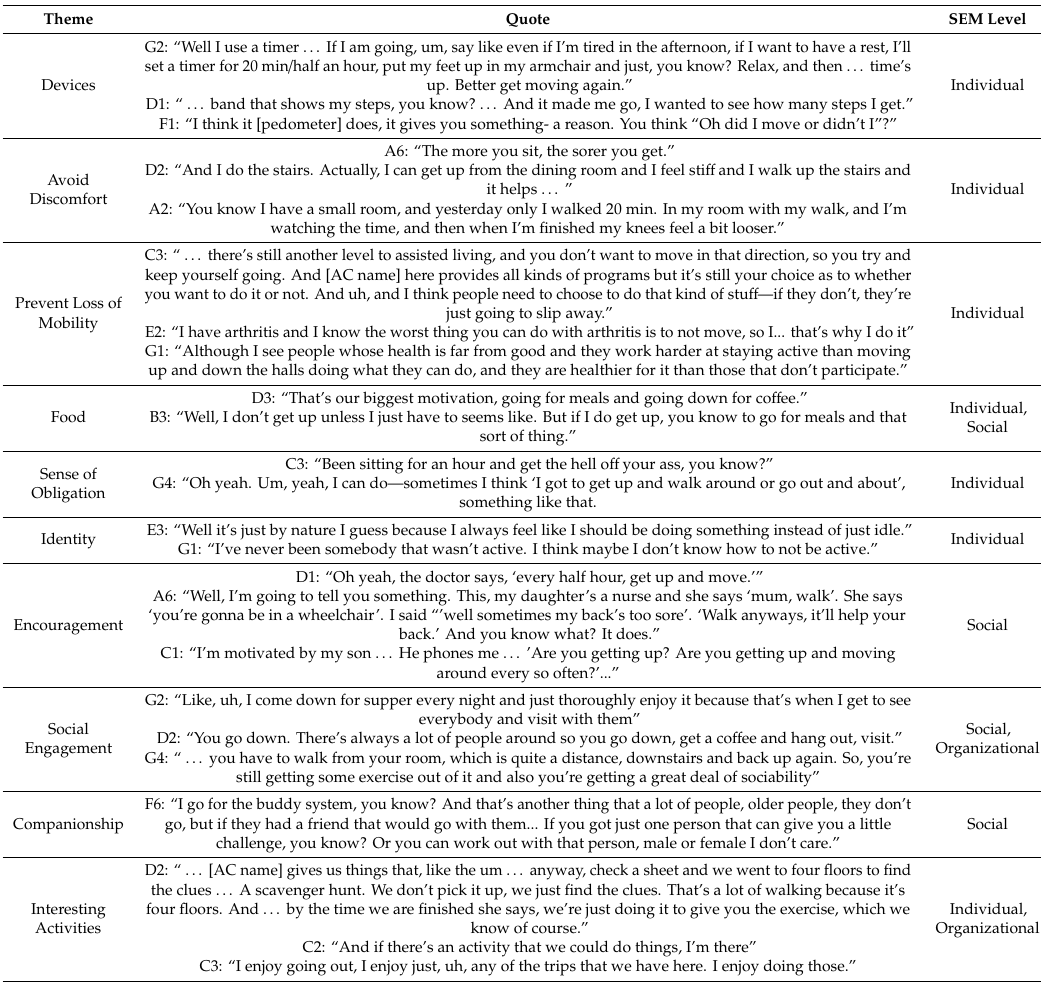
Table 1. Themes related to motivators for reducing sedentary time among older adults in assisted living, and associated level(s) of the Social Ecological Model